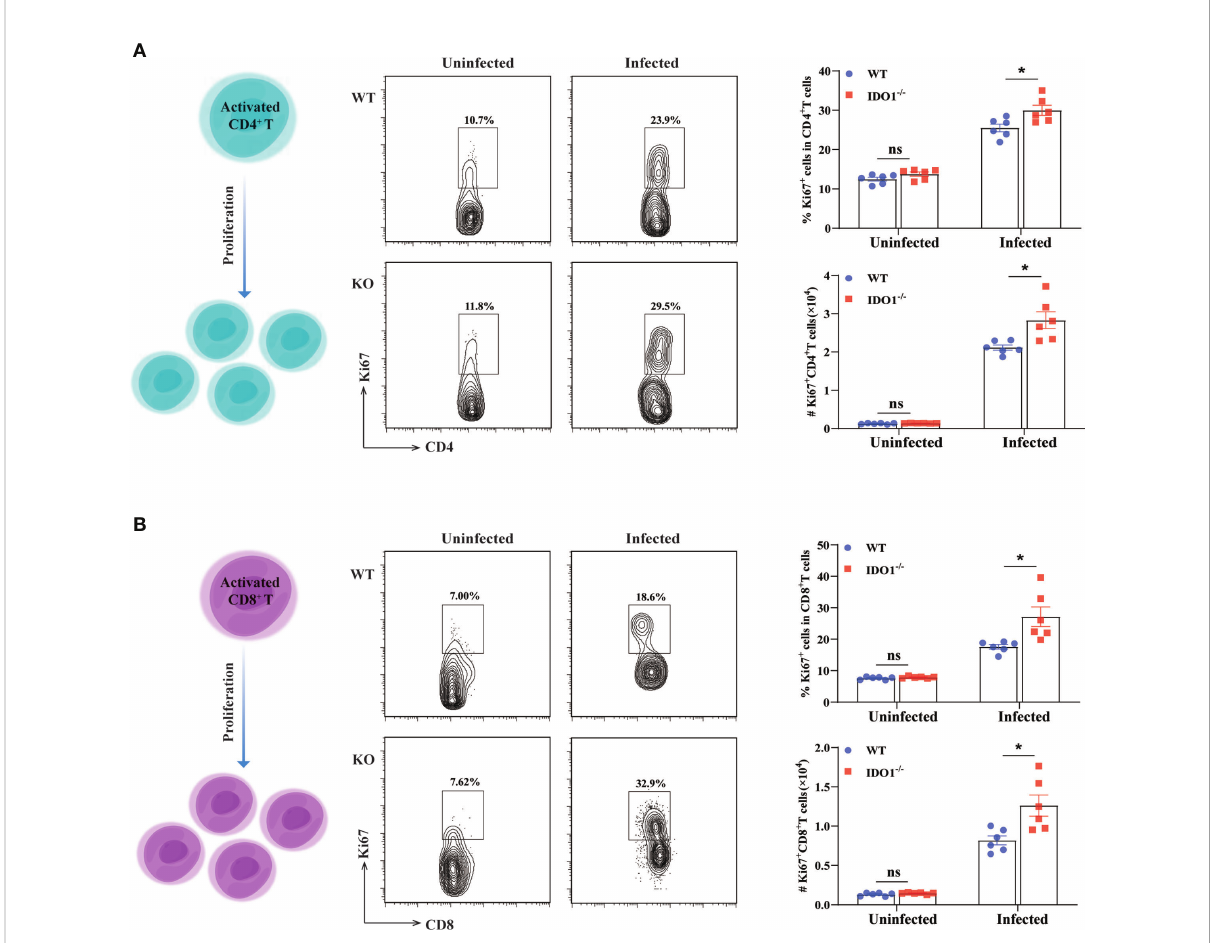
FIGURE 5 Enhanced proliferation of T cells in IDO1 -/- mice infected with E multilocularis. (A, B) Conceptual schematic diagram (left), representative fl ow cytometry plots (middle), and the frequency (upper right) and the absolute number (lower right) of proliferating CD4 + T cells (A) and CD8 + T cells (B) of the IDO1 -/- and wild-type mice at 3 months post-infection with E multilocularis (n = 6/group). CD45 + CD3 + CD4 + and CD45 + CD3 + CD8 + cells were gated respectively for panel (A, B) . Data are pooled from 2 independent experiments, and presented as the mean ± SEM. ns, not signi fi cant; *, p <